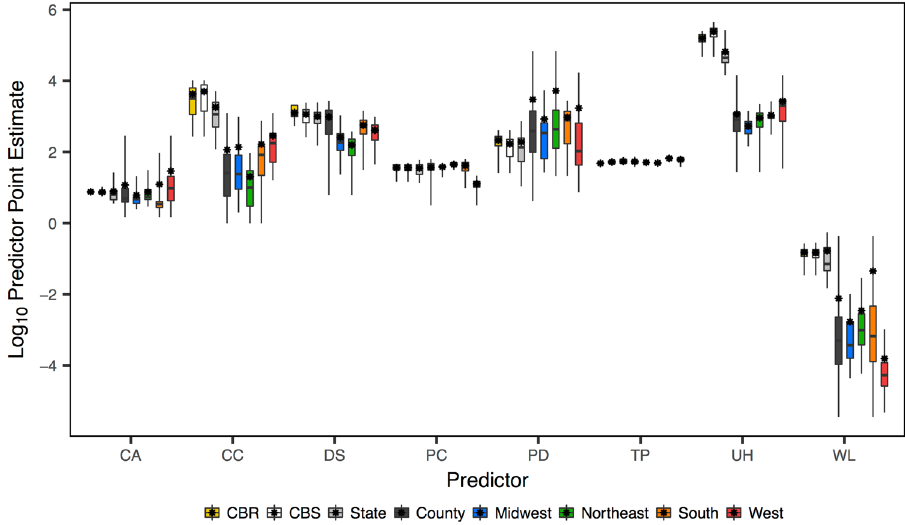
Figure 4. Predictor point estimate distributions for each model. Predictor abbreviations are: Corvidae average counts (CA), case counts (CC), distance (DS), precipitation (PC), population density (PD), temperature (TP), expected unvaccinated horses (UH), and wetlands area (WL).